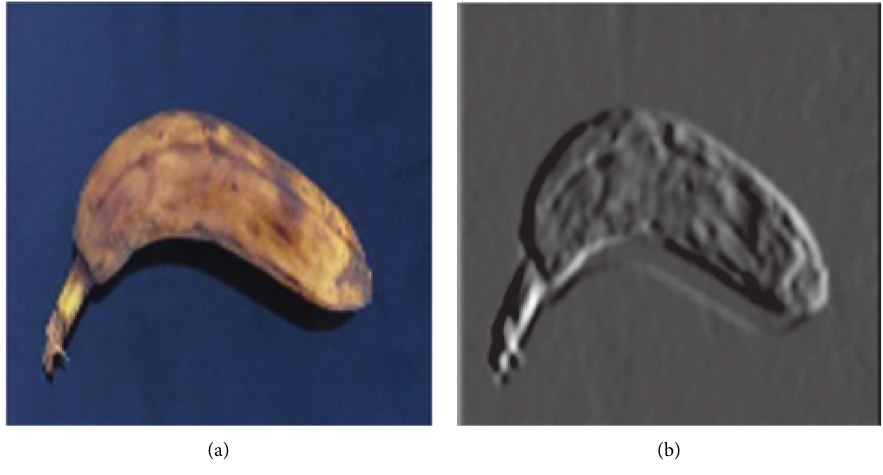
Figure 10: Strongest activations of a banana image. (Figure 10(a)) from the same convolution layer in Figure 9.